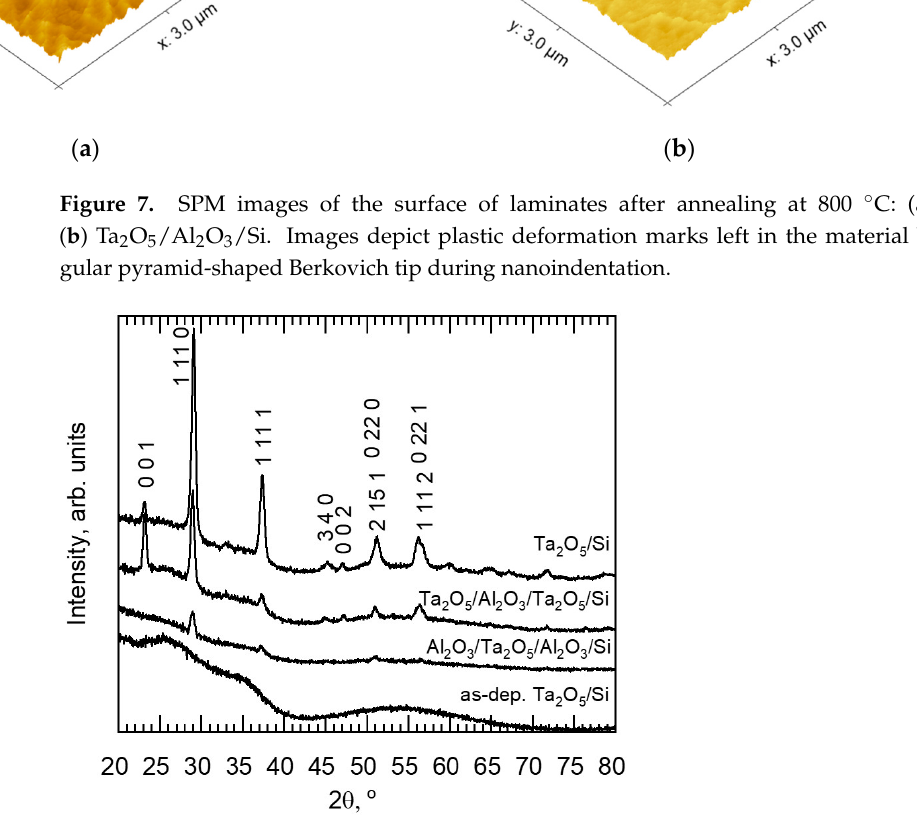
Figure 8. Di ff ractograms of as-deposited Ta 2 O 5 /Si and three fi lms that revealed crystallinity after Figure 8. Diffractograms of as-deposited Ta 2 O 5 /Si and three films that revealed crystallinity after annealing at 700 ◦ C. Reflection indices of orthorhombic Ta 2 O 5 (PDF 00-025-0922)